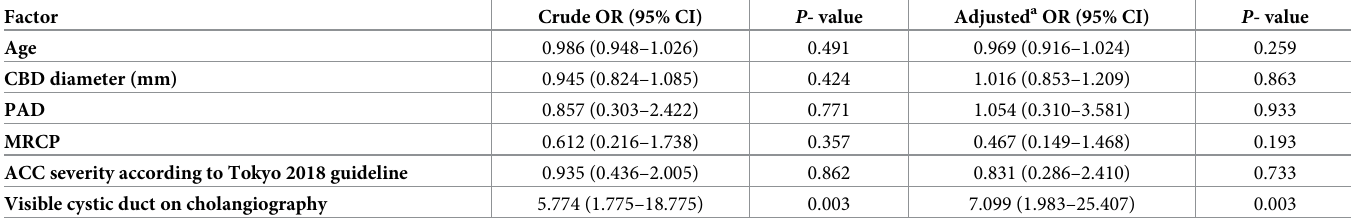
ACC severity according to Tokyo 2018 guideline Visible cystic duct on cholangiography OR odds ratio, CI confidence interval, CBD common bile duct, PAD periampullary diverticulum, MRCP magnetic resonance cholangiopancreatograph, ACC acute calculus cholecystitis. a Adjusted for all the variables in the